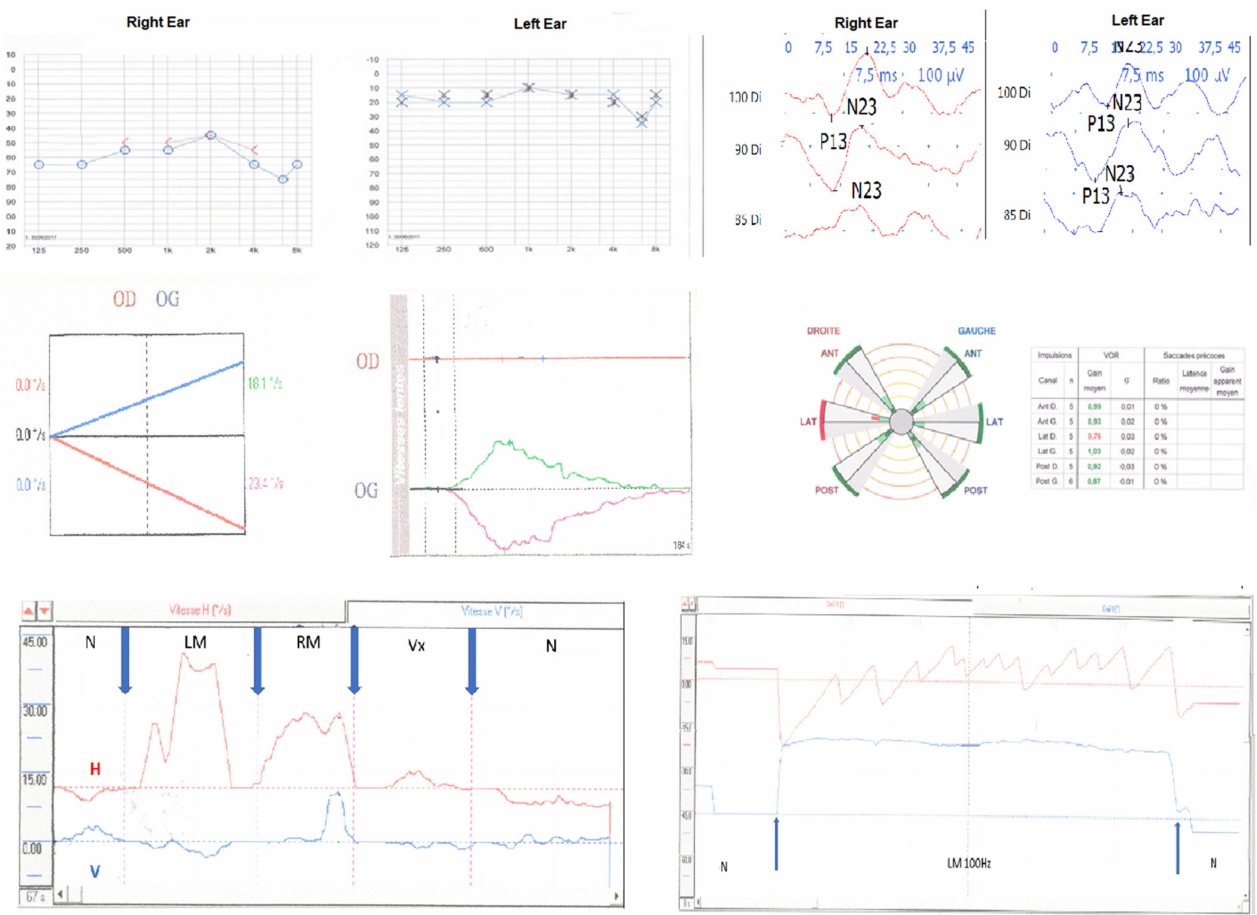
Figure 2. Example of vestibular test results for a typical patient operated on the right side. From up to down and left to right: PTA: moderate hearing loss on the right ear; preservation of cVEMP responses; caloric test: right caloric areflexia; VHIT: isolated and moderate hypofunction of the sole horizontal semicircular canal (gain = 0.76); SVINT: strong SVIN beating toward the intact side (SVIN-SPV = 16 ◦ /s); H = horizontal component, V = vertical component (the vestibular AAO subjective scale score = 1; DHI score =